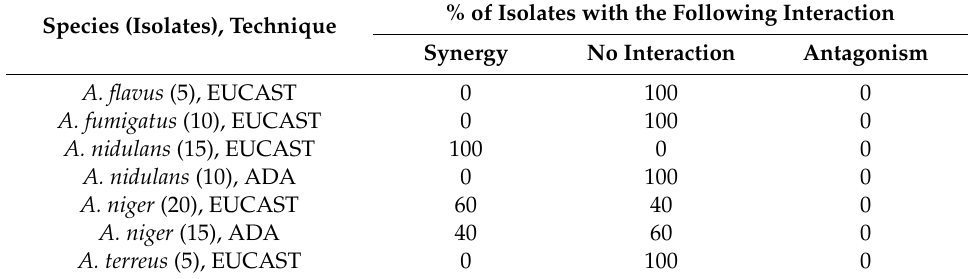
Table 3. Summary of in vitro interactions of isavuconazole with colistin against Aspergillus species using EUCAST broth microdilution checkerboard methodology and agar di ff usion assay. Species (Isolates), Technique